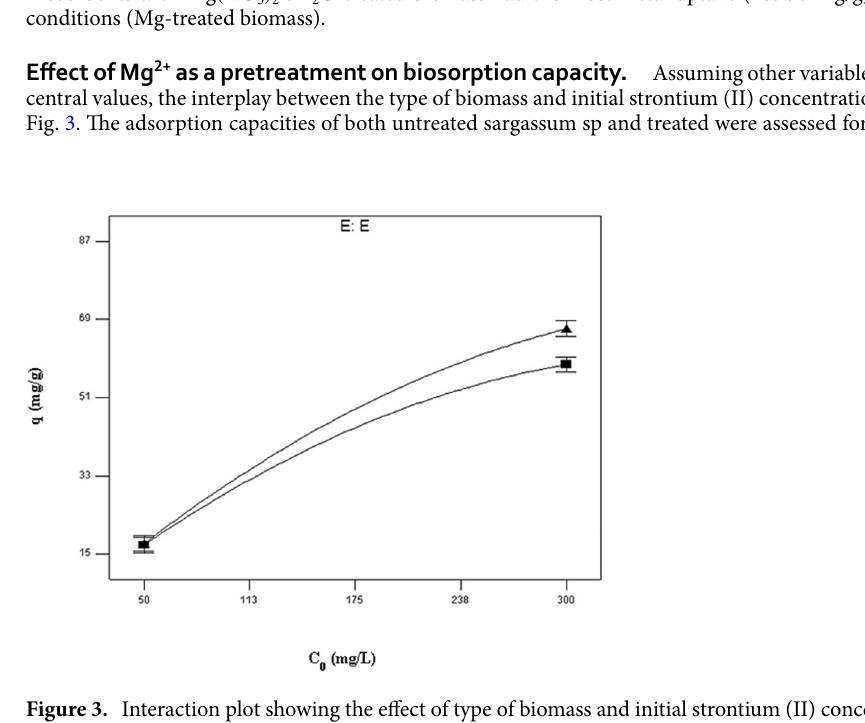
Figure 3. Interaction plot showing the effect of type of biomass and initial strontium (II) concentration on the strontium uptake of biomass holding other variables at their central